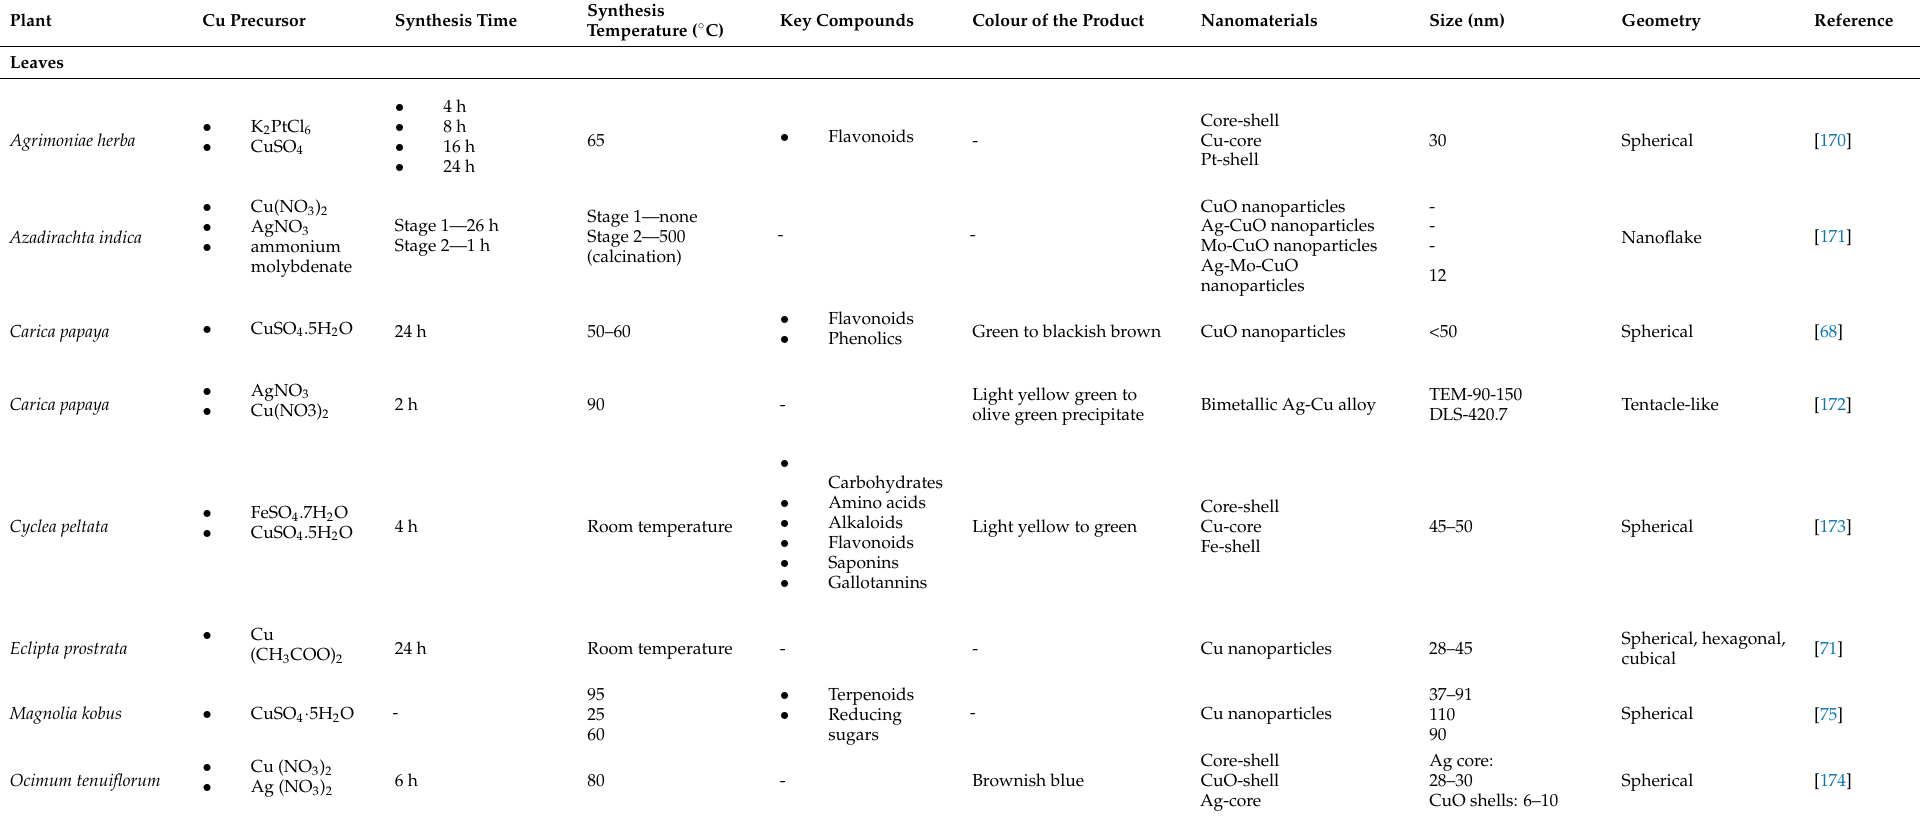
Table 3. Summary of plant-mediated Cu nanomaterial synthesis: plant extract type, key compounds, Cu precursors, synthesis time and temperature, reaction completion colour, and the Cu nanomaterial product, geometry, and